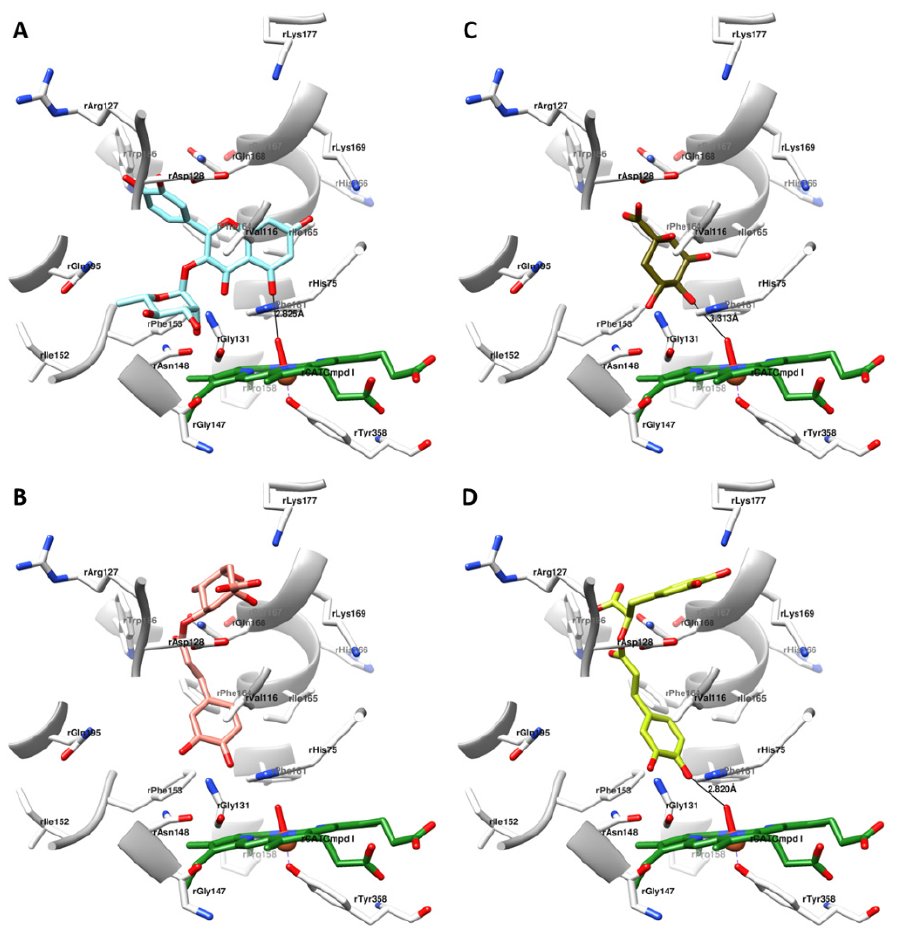
Figure 2. The bioactive conformations of quercitrin ( A ), chlorogenic acid ( B ), quinic acid ( C ), and rosmarinic acid ( D ) within the r CATCmpd I. Amino acid residues are depicted in white, and hem containing the oxoferryl porphyrin π -cation radical is colored green. For the clarity of presentation, only polar hydrogen atoms are presented within the naturally occurring compounds.